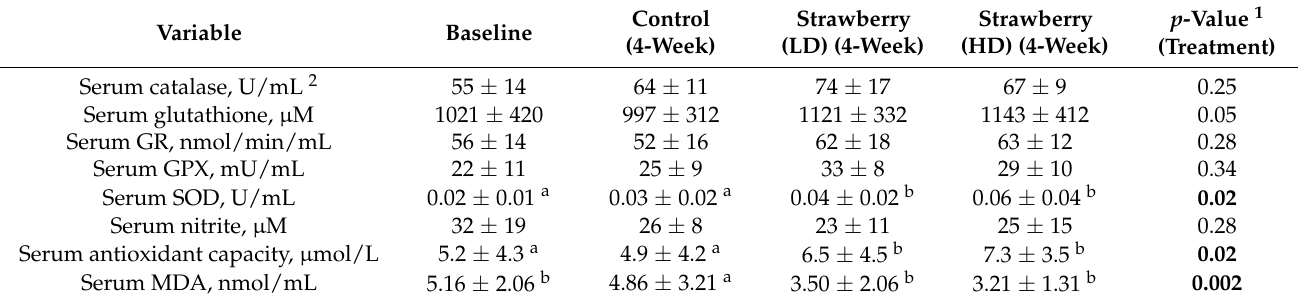
Table 1. Serum antioxidants and oxidative stress biomarkers in adults with the metabolic syndrome following control, low, and high-dose strawberry powder for a period of four weeks each in a randomized crossover study.